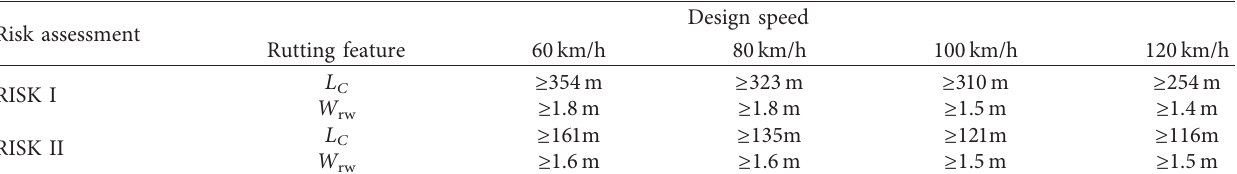
Table 6: Safety margins of rutting width and length for RISK I and RISK II.